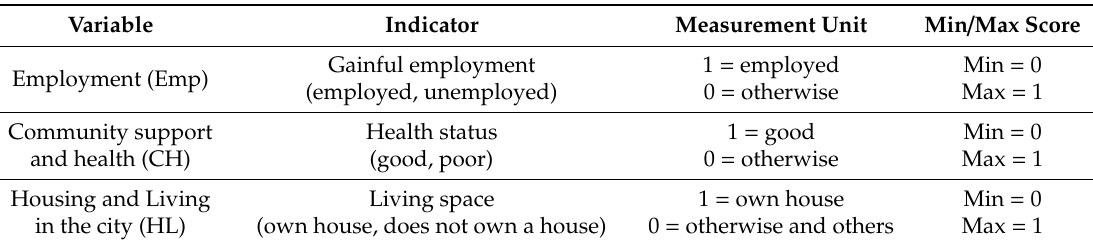
Table 2. Variables and measures of active ageing indices and socio-economic